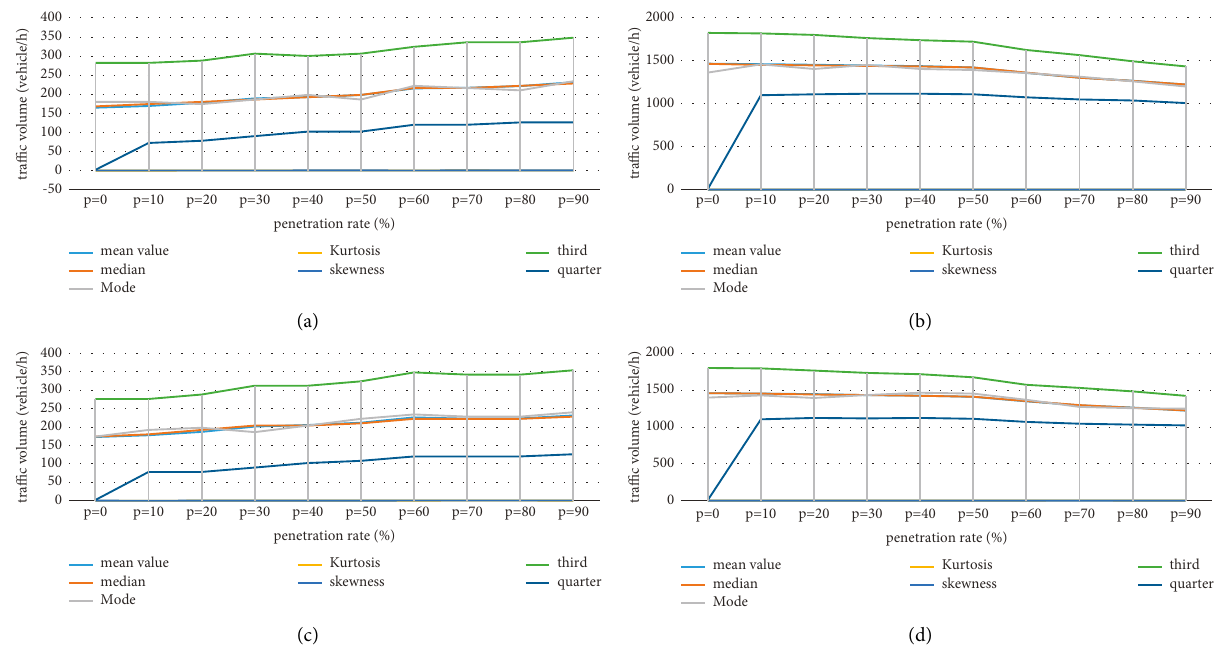
Figure 7: Traffic volume characteristic map of different lanes under different penetration rate of autonomous vehicles. (a) Traffic volume characteristic map in lane 1. (b) Traffic volume characteristic map in lane 2. (c) Traffic volume characteristic map in lane 3. (d) Traffic volume characteristic map in lane 4.